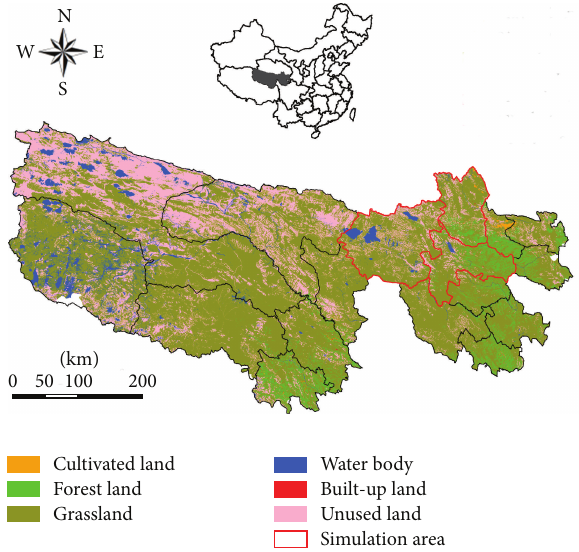
Figure 1: The location of study area. The simulation area, a continuous region involving all the land use types, was selected to implement the simulation with the ABM model. This figure shows the land use map in